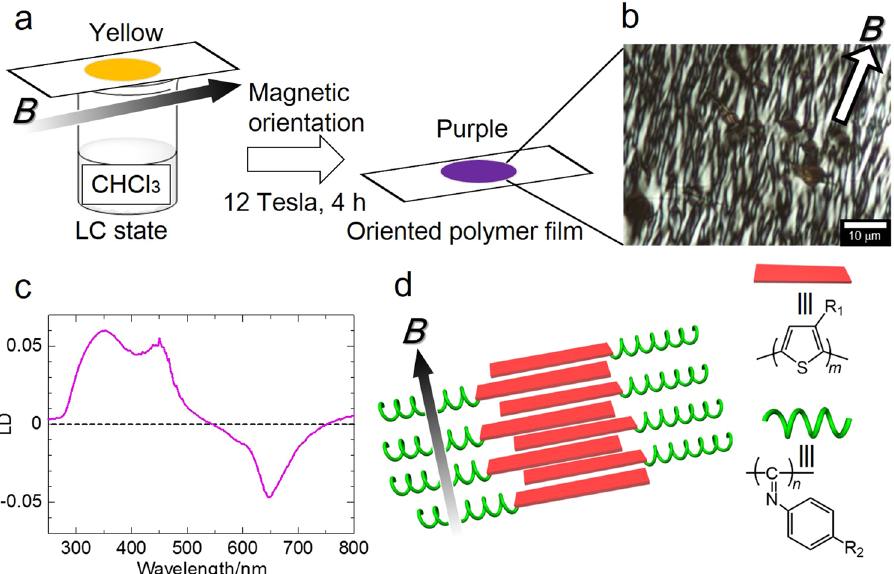
Figure 4. Magnetic orientation of PTh- b -PPI film. ( a ) Schematic representation of magnetic orientation of PTh- b -PPI film with exposure to chloroform vapour. ( b ) POM image of magnetically oriented PTh- b -PPI film. ( c ) Linear dichroism (LD) spectrum of magnetically oriented PTh- b -PPI film. ( d ) Schematic illustration of magnetically oriented PTh- b -PPI . Here, the parallel direction is along the direction of the magnetic